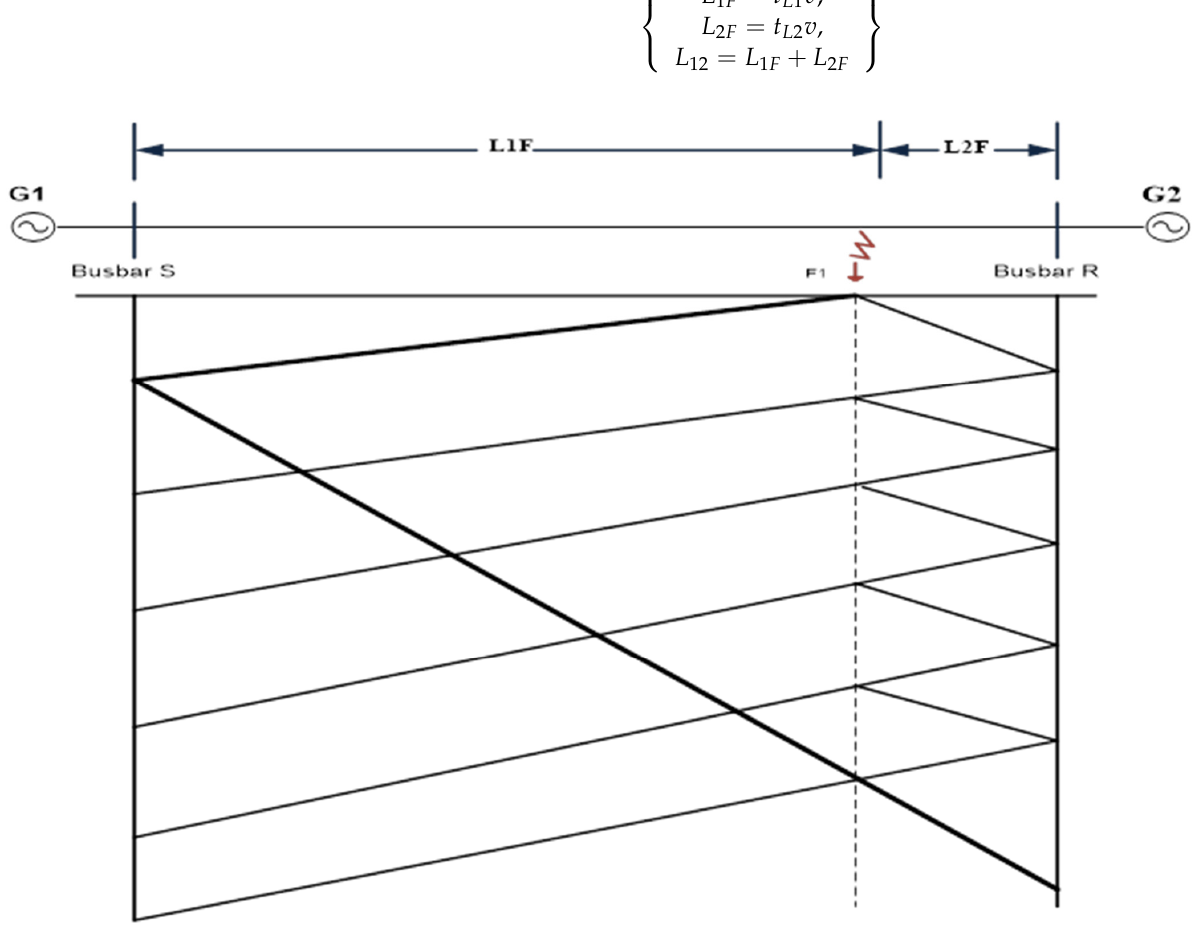
Figure 3. Bewley’s lattice diagram for two-terminal traveling-wavelet-based fault-location principle. In this fault-locating algorithm, the DWT detects the transient-traveling-wavelet head, which is further used to locate the fault point and is written as: A three-phase system was taken into account in which the electromagnetic coupling of each phase can affect the accuracy of the fault location. There is a need for such a transformation, in which three-phase nonindependent components are converted into mutually independent mode components, as per Clarke-transformation matrices [49]. The proposed model transformation is formulated